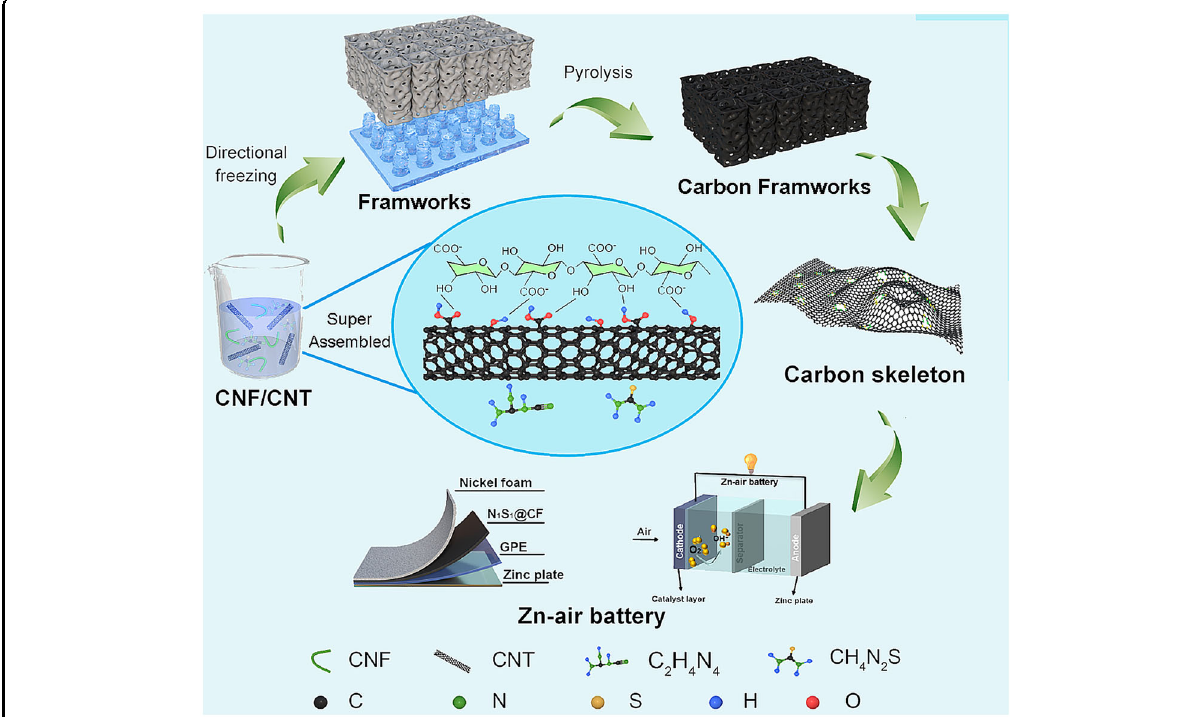
Fig. 1 The synthesis process of N 1 S 1 @CF. The schematic showed the CNF/CNT mixture is fi rstly assembled by H-bonds. Then the carbon framwork is fabricated by freeze-drying and pyrolysis, which can be used in